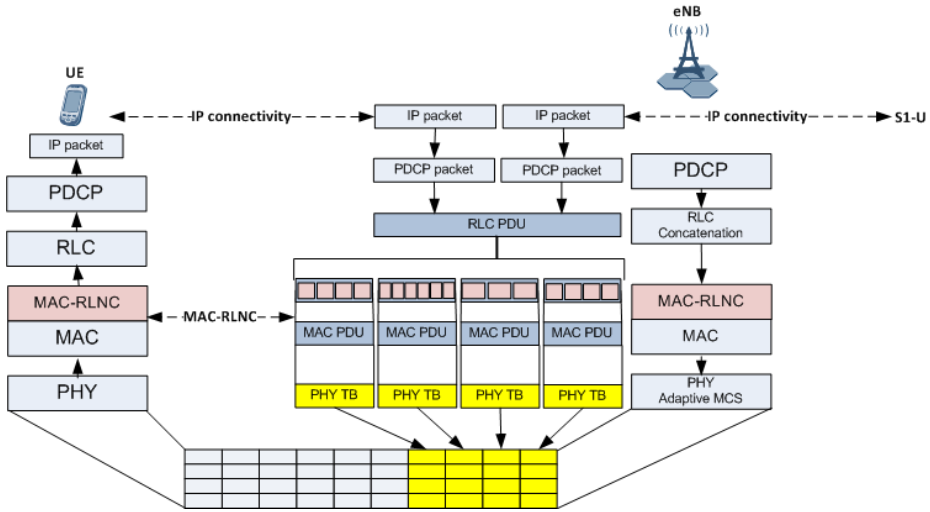
Figure 5. MAC-RLNC sublayer as part of LTE RAN protocol